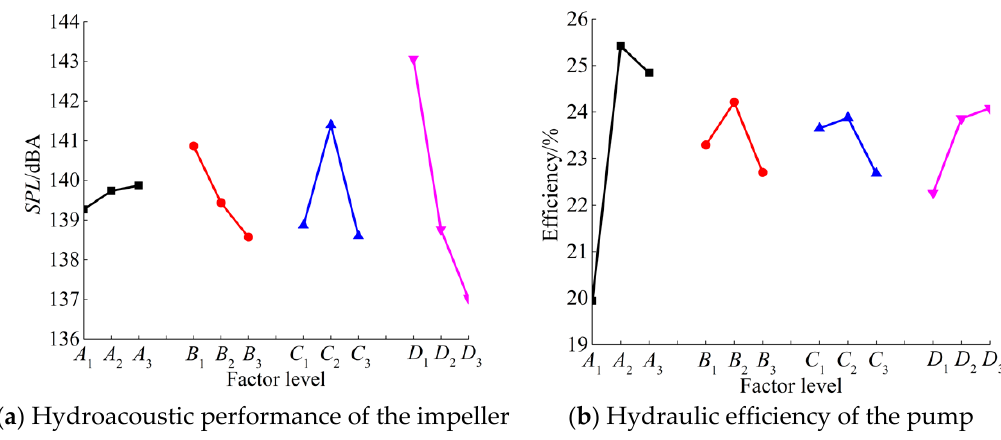
Figure 26. Effective curves of optimization indexes. Figure 26. E ff ective curves of optimization indexes.